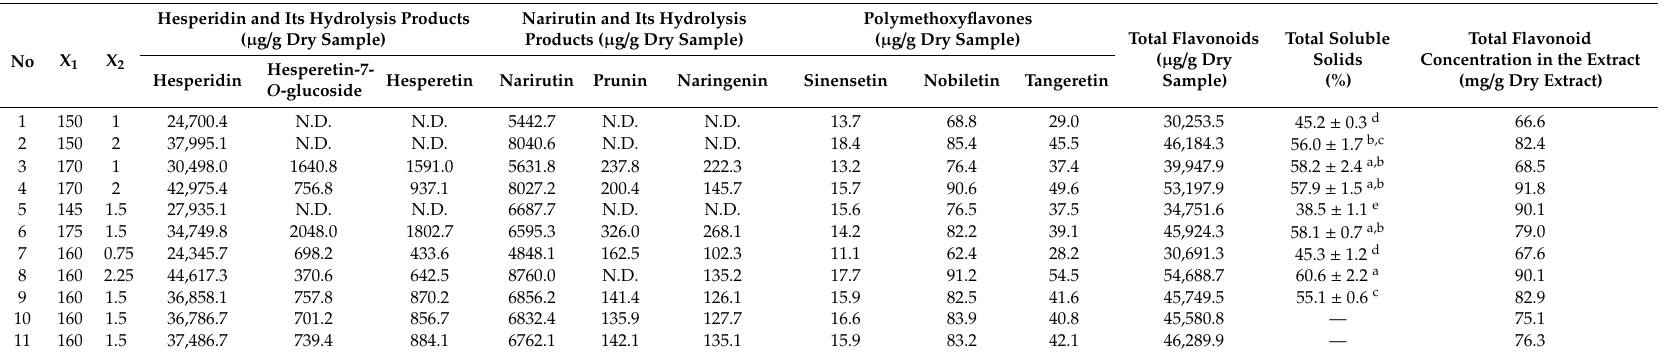
Table 1. Central composite design and corresponding flavonoid and total soluble solid yields in subcritical water extracts from C. unshiu peel. Hesperidin and Its Hydrolysis Products ( µ g / g Dry Sample) No X 1 X 2